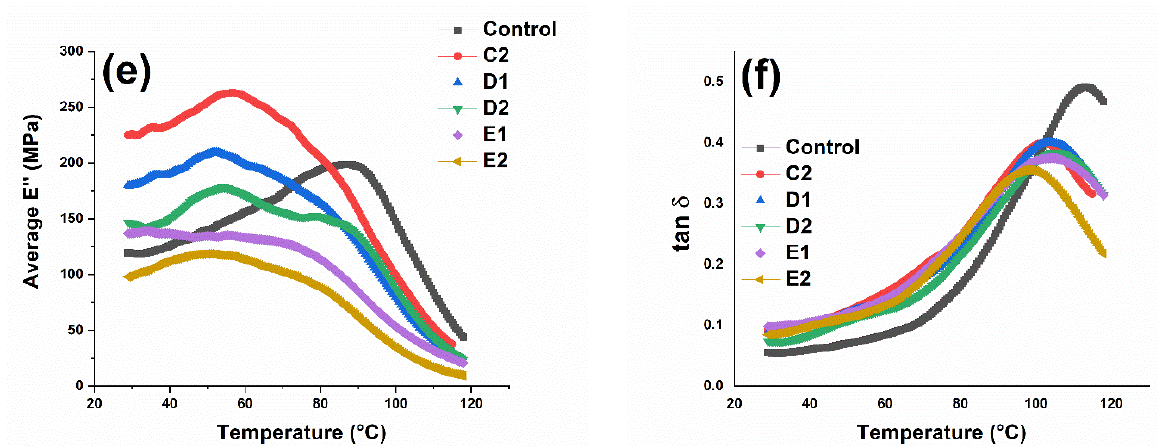
Figure 5. ( a ) Average storage modulus curve (E’) for CPH reinforced composite. ( b ) Average loss modulus curve (E”) for CPH reinforced composite. ( c ) Average damping factor tan δ for CPH reinforced composite. ( d ) Average storage modulus curve (E’) for hybrid composite. ( e ) Average loss modulus curve (E”) for hybrid composite. ( f ) Average damping factor tan δ for hybrid composite.